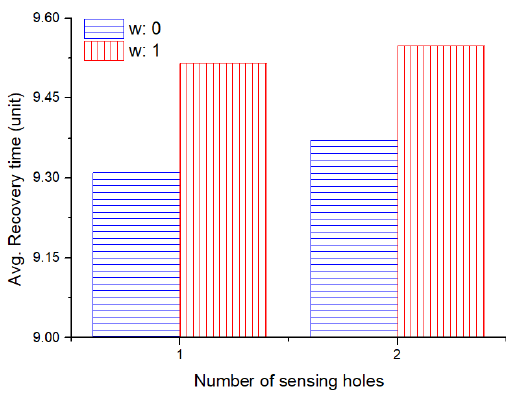
Figure 12. The average recovery time according to weight w .